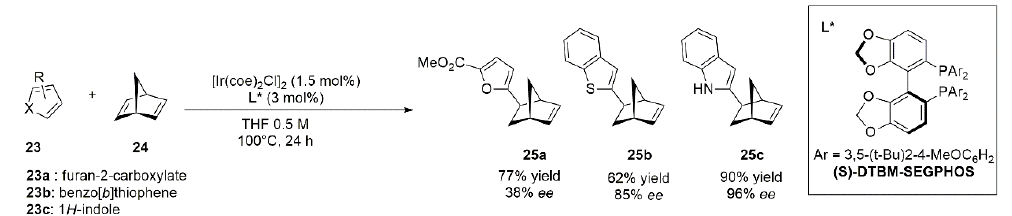
Figure 15 . Intermolecular asymmetric addition of heteroaromatic compounds to bicycloalkenes.